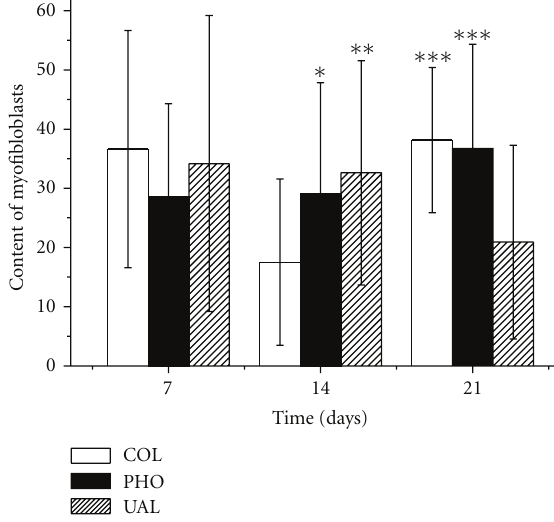
Figure 6: Quantitative analysis of the myofibroblasts content in the studied groups seven, 14 and 21 days after the burn proce- dures (COL—collagen-based dressing films; PHO—phospholipids- containing collagen-based dressing films; UAL—liposome-loaded usnic acid-containing dressing films). ∗ Di ff erent from COL P = . 005; ∗∗ Di ff erent from COL P = . 000; ∗∗∗ Di ff erent from UAL P = . 000; ∗∗∗∗ Di ff erent from UAL P = . 002.